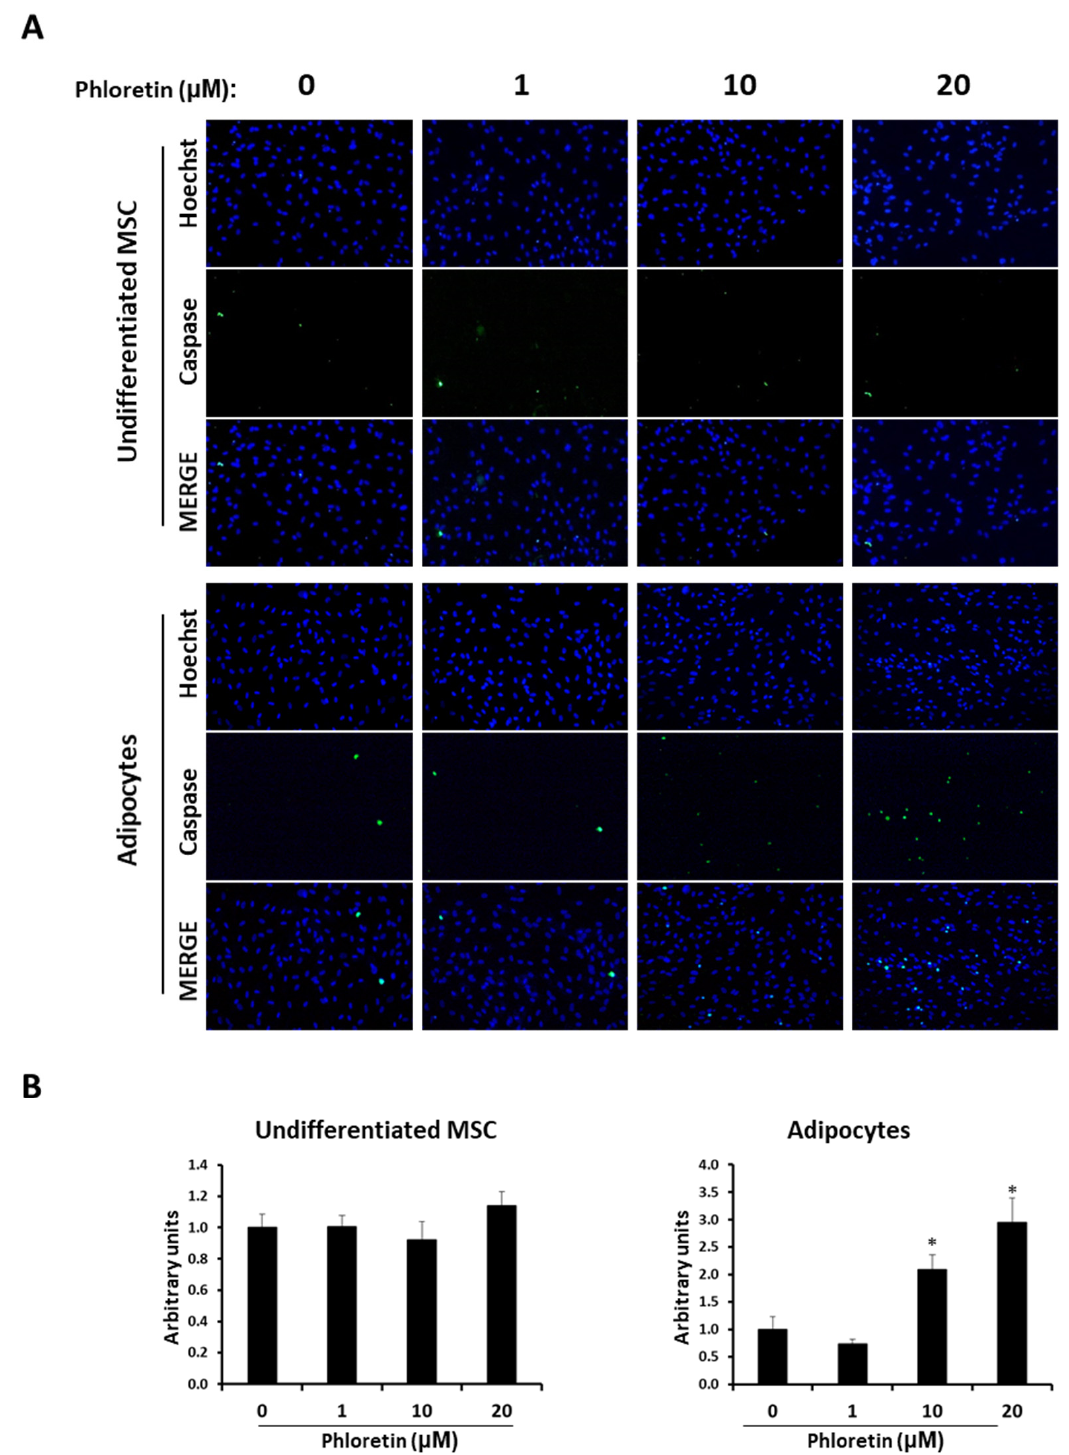
Figure 9. Phloretin increases apoptosis in MSC differentiated into adipocytes. ( A ) Representative fluorescent-microscopy pictures of Hoechst-stained nuclei and caspase 3/7-positive cells at day 13 in MSC undifferentiated or differentiated into adipocytes, in presence of 0, 1, 10, or 20 µ M of phloretin. ( B ) Quantification of caspase 3/7-positive cells, by image analyses, in undifferentiated and adipocyte-differentiated MSC. Hoechst staining was used to normalize the number of caspase 3/7-positive cells in each image. * p < 0.05 vs. cultures no treated (0 µ M of phloretin).